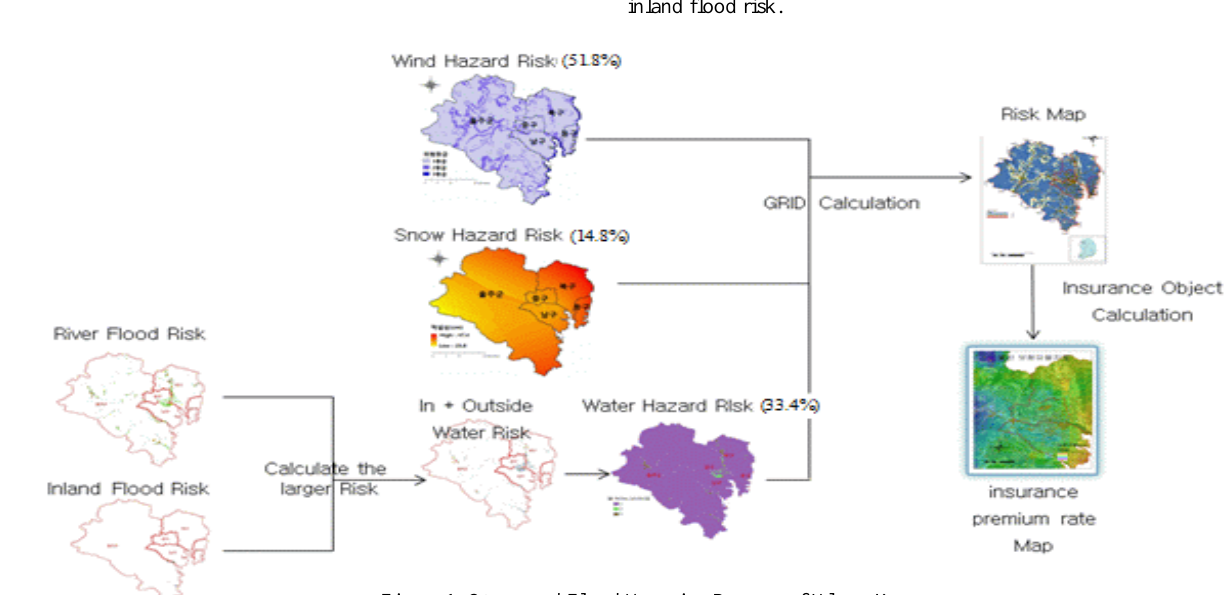
Figure 1. Storm and Flood Mapping Process of Ulsan,